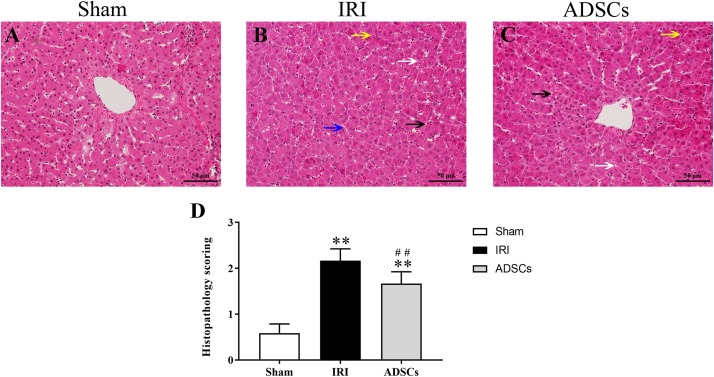
Histopathological changes and score in the liver post-IR. HE-stained liver tissues in the (A) sham-operated, (B) IRI, and (C) ADSCs groups. Black arrows indicate hemorrhage, white arrows indicate hepatocyte vacuolar degeneration, blue arrow indicates hepatic cord structural disorder, and yellow arrows indicate inflammatory cell infiltration (Magnification × 200). (D) Histopathology score. ∗∗P < 0.01, vs. sham group; ##P < 0.01, vs. IRI group.